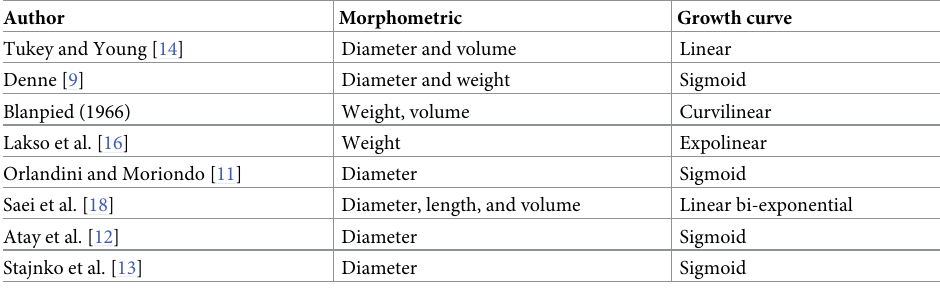
Table 1. Summary of growth studies for apple development.